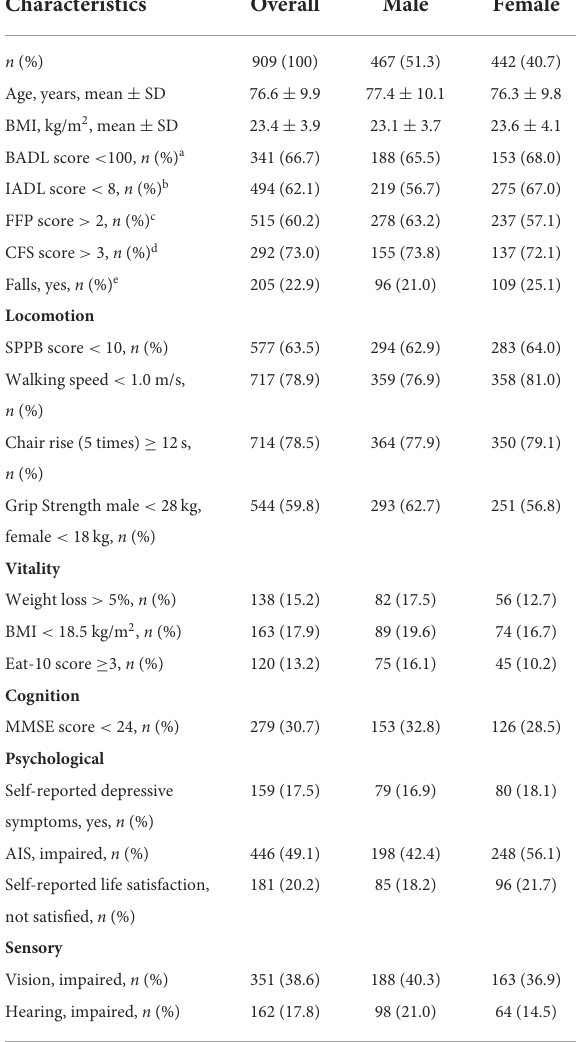
TABLE 1 Characteristics of the